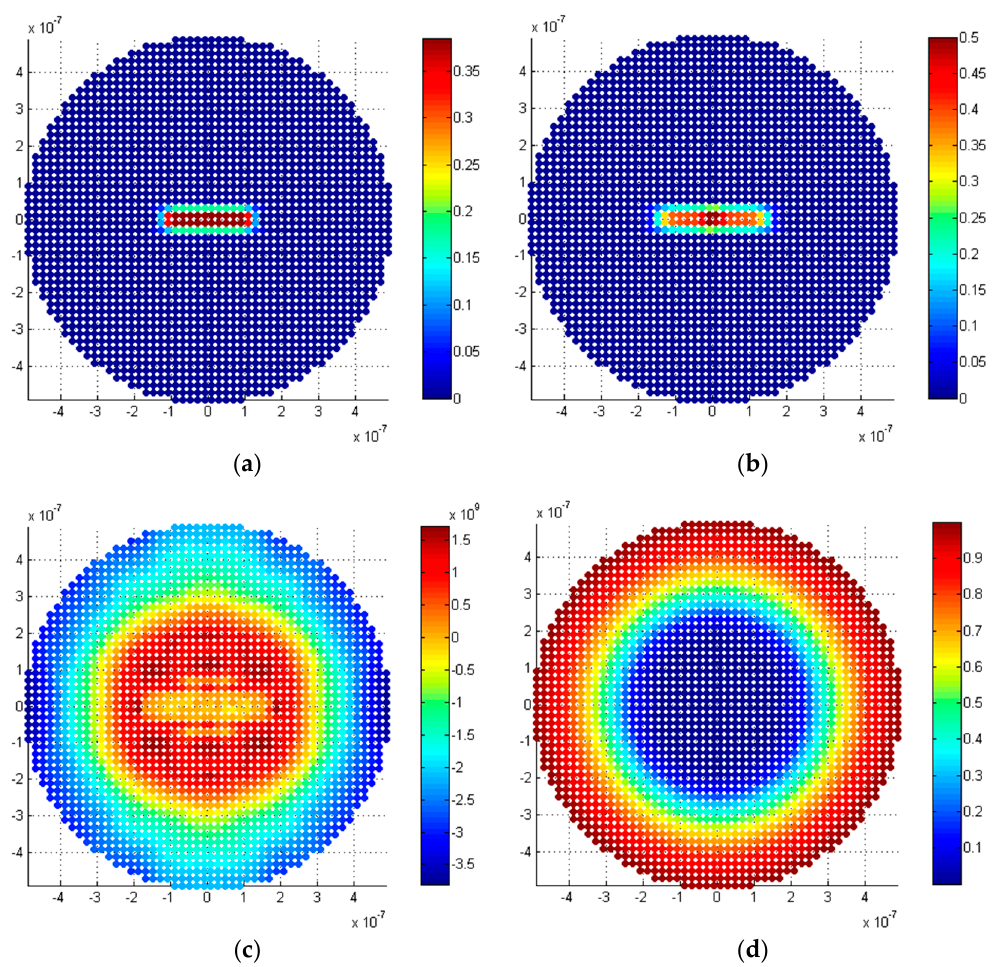
Figure 4. Results for a penny-shaped, cracked anode in the x - z mid-plane: ( a ) initial damage; ( b ) new damage; ( c ) hydrostatic stress; and ( d ) lithium ion concentration.